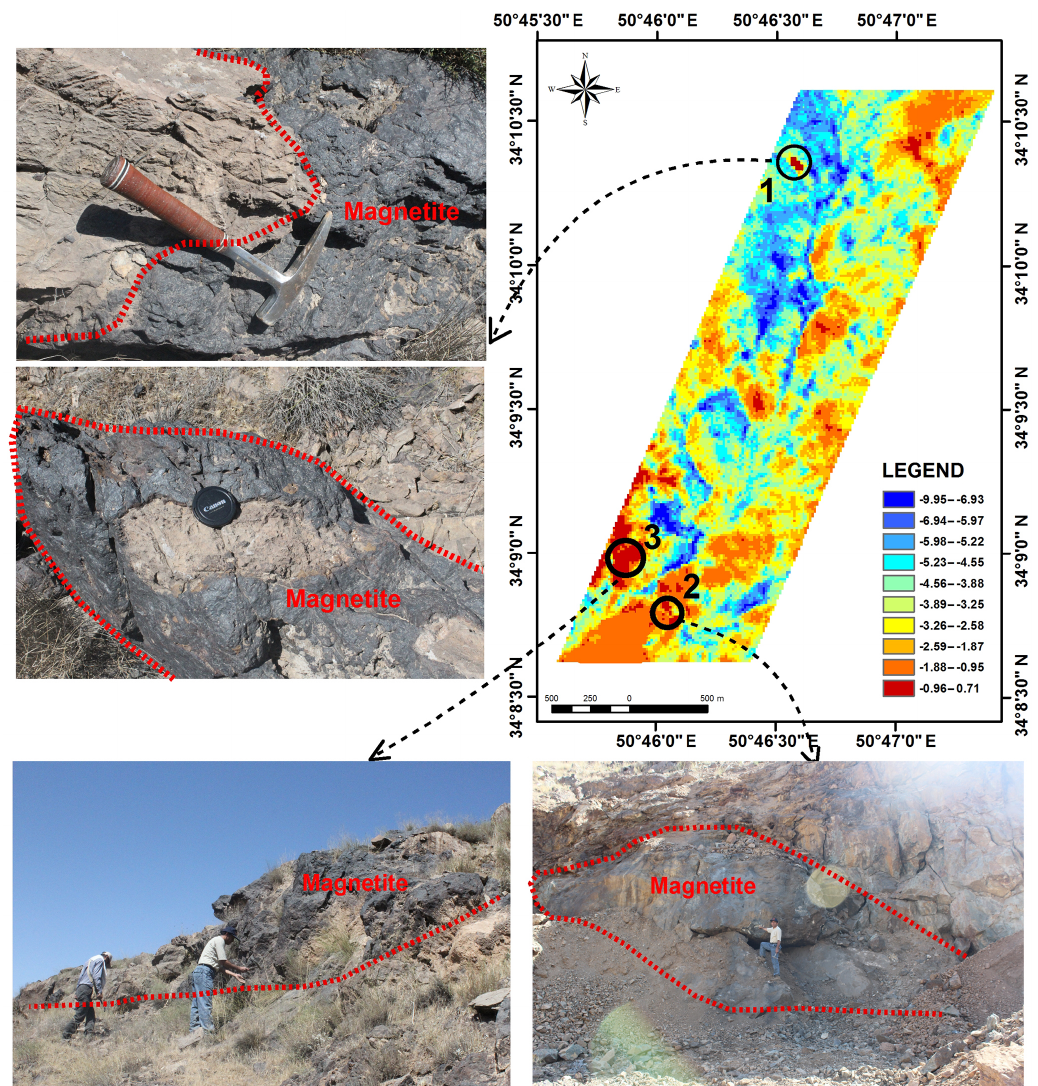
Figure 6. Mineral prospectivity map of the Sarvian area, which was confirmed by a field sample of the three target